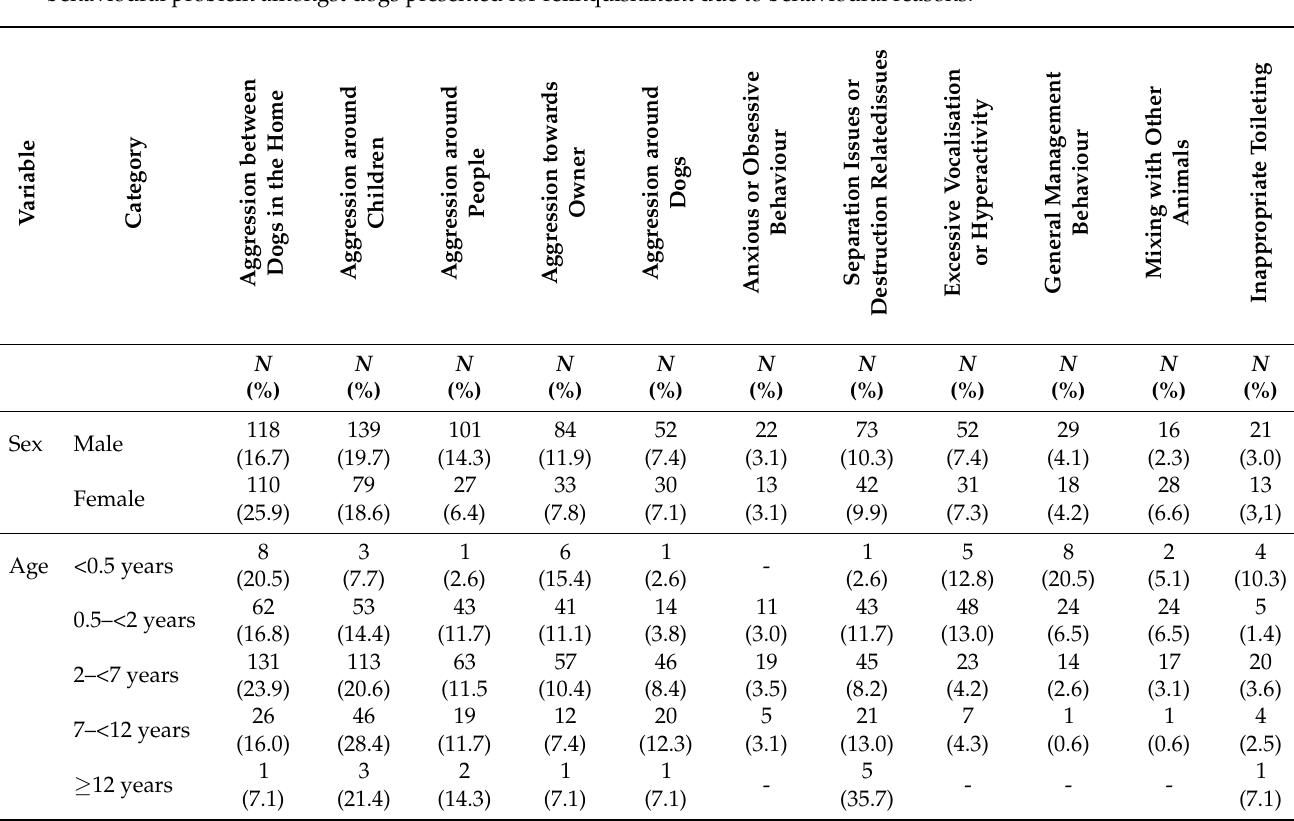
Table 4. Descriptive statistics showing the count and percentage of each sex and age group category presenting for each behavioural problem amongst dogs presented for relinquishment due to behavioural reasons.